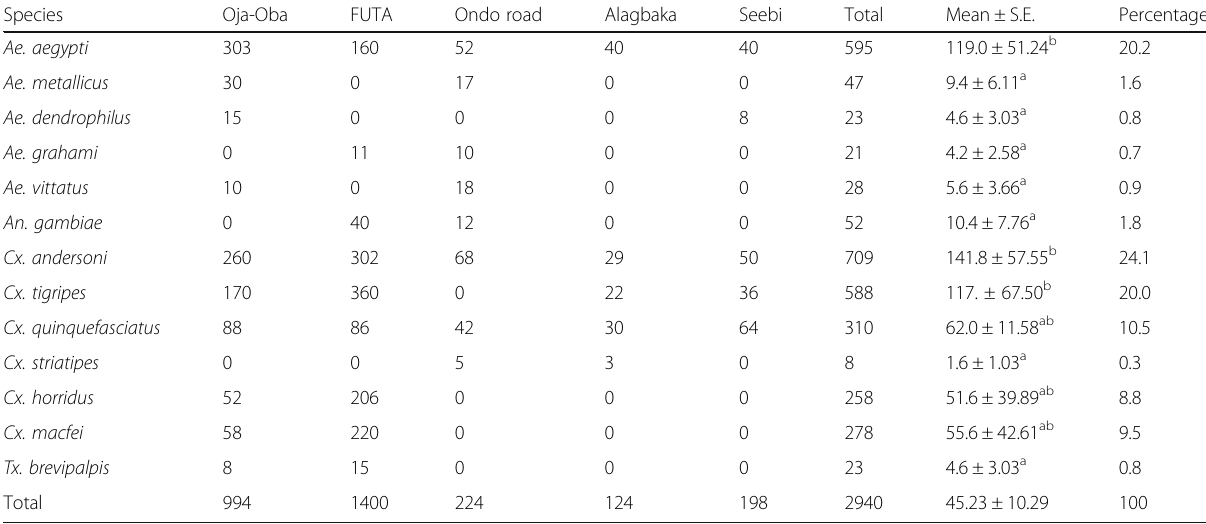
Table 4 The distribution and abundance of mosquito species in Akure South Local Government